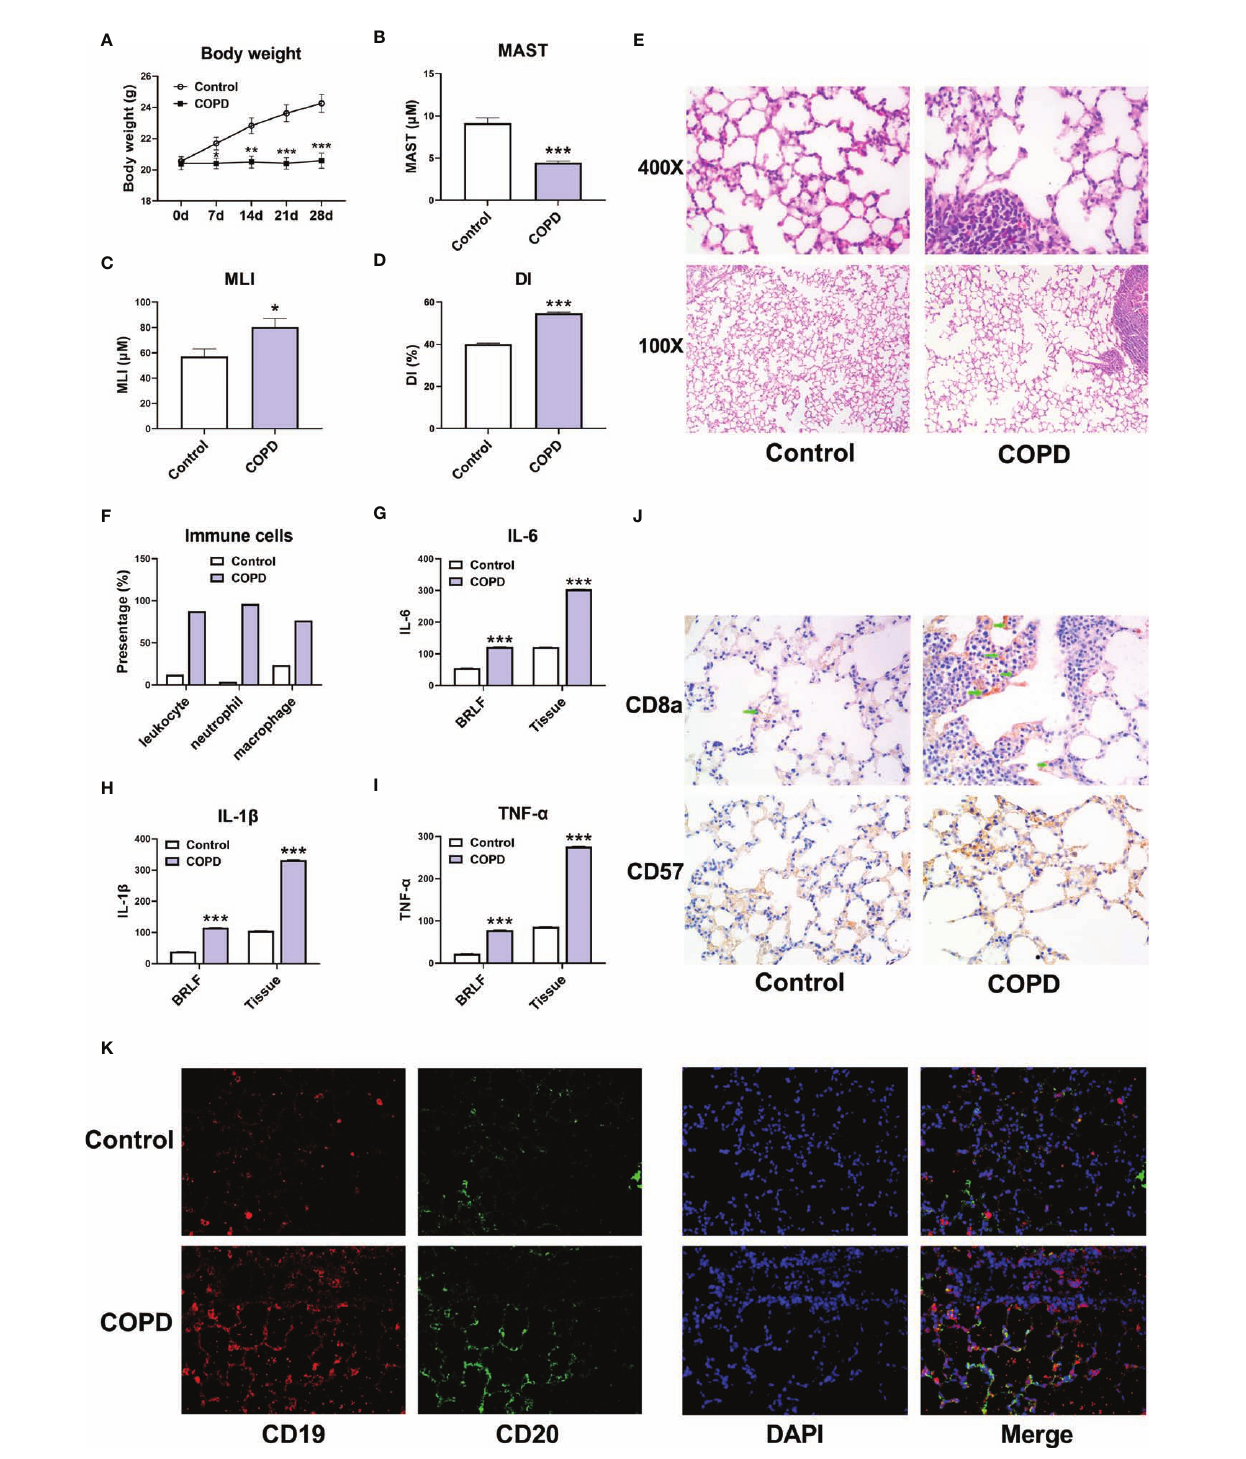
FIGURE 8 | Immune cell in fi ltration in COPD mouse models. (A) Body weight of mice. (B) The mean alveolar septal thickness (MAST). (C) Mean linear intercept (MLI). (D) Destructive index (DI). (E) Representative HE staining images (100x and 400x). (F) The proportion of immune cells. (G) The expression of IL-6 in bronchoalveolar lavage fl uid (BRLF) and lung tissues of mice. (H) The expression of IL-1 b in BRLF and lung tissues of mice. (I) The expression of TNF- a in BRLF and lung tissues of mice. (J) Representative immunohistochemistry images of CD8a and CD57 (400x). (K) Representative immuno fl uorescence images of CD19 and CD20 (400x). For panel G, H, and I, the unit for BRLF is pg/mL, and the unit for lung tissue is pg/mg. *P < 0.05, **P < 0.01, ***P < 0.001 vs.